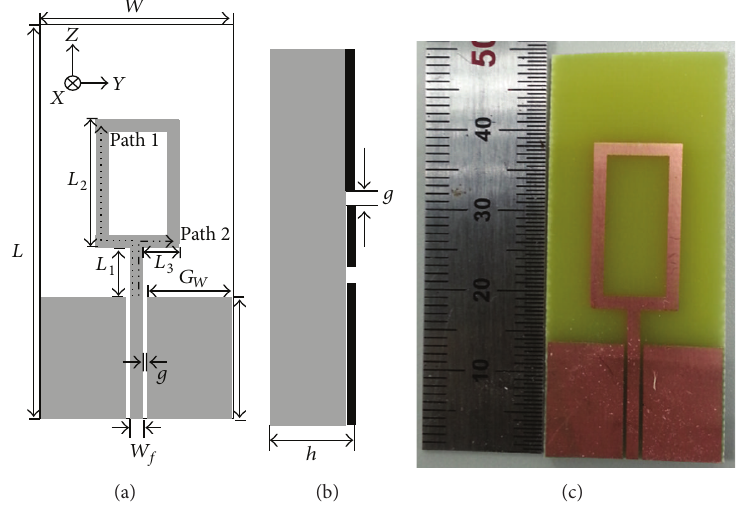
Figure 1: Geometry of the printed rectangular ring antenna: (a) top view and (b) side view. (c) Photograph of the fabricated antenna. −50−45−40−35−30−25−20−15−10−50 d ( 11 S